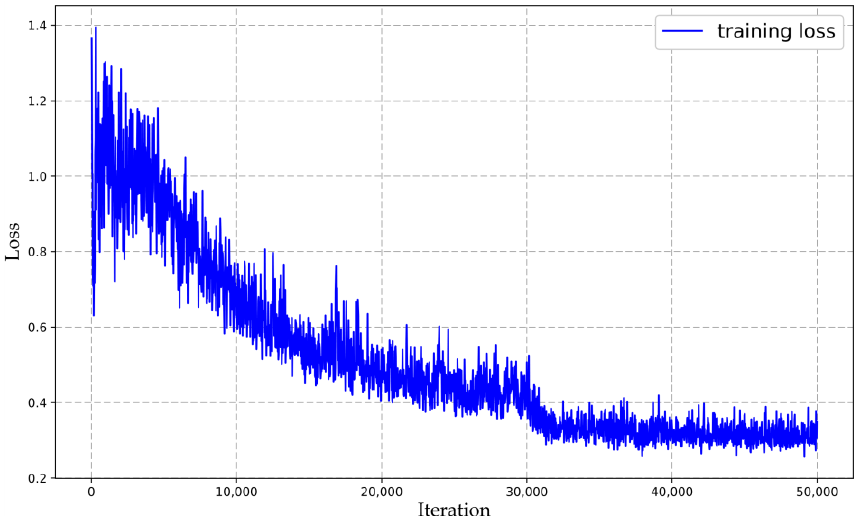
Figure 9. The curve of loss of training.